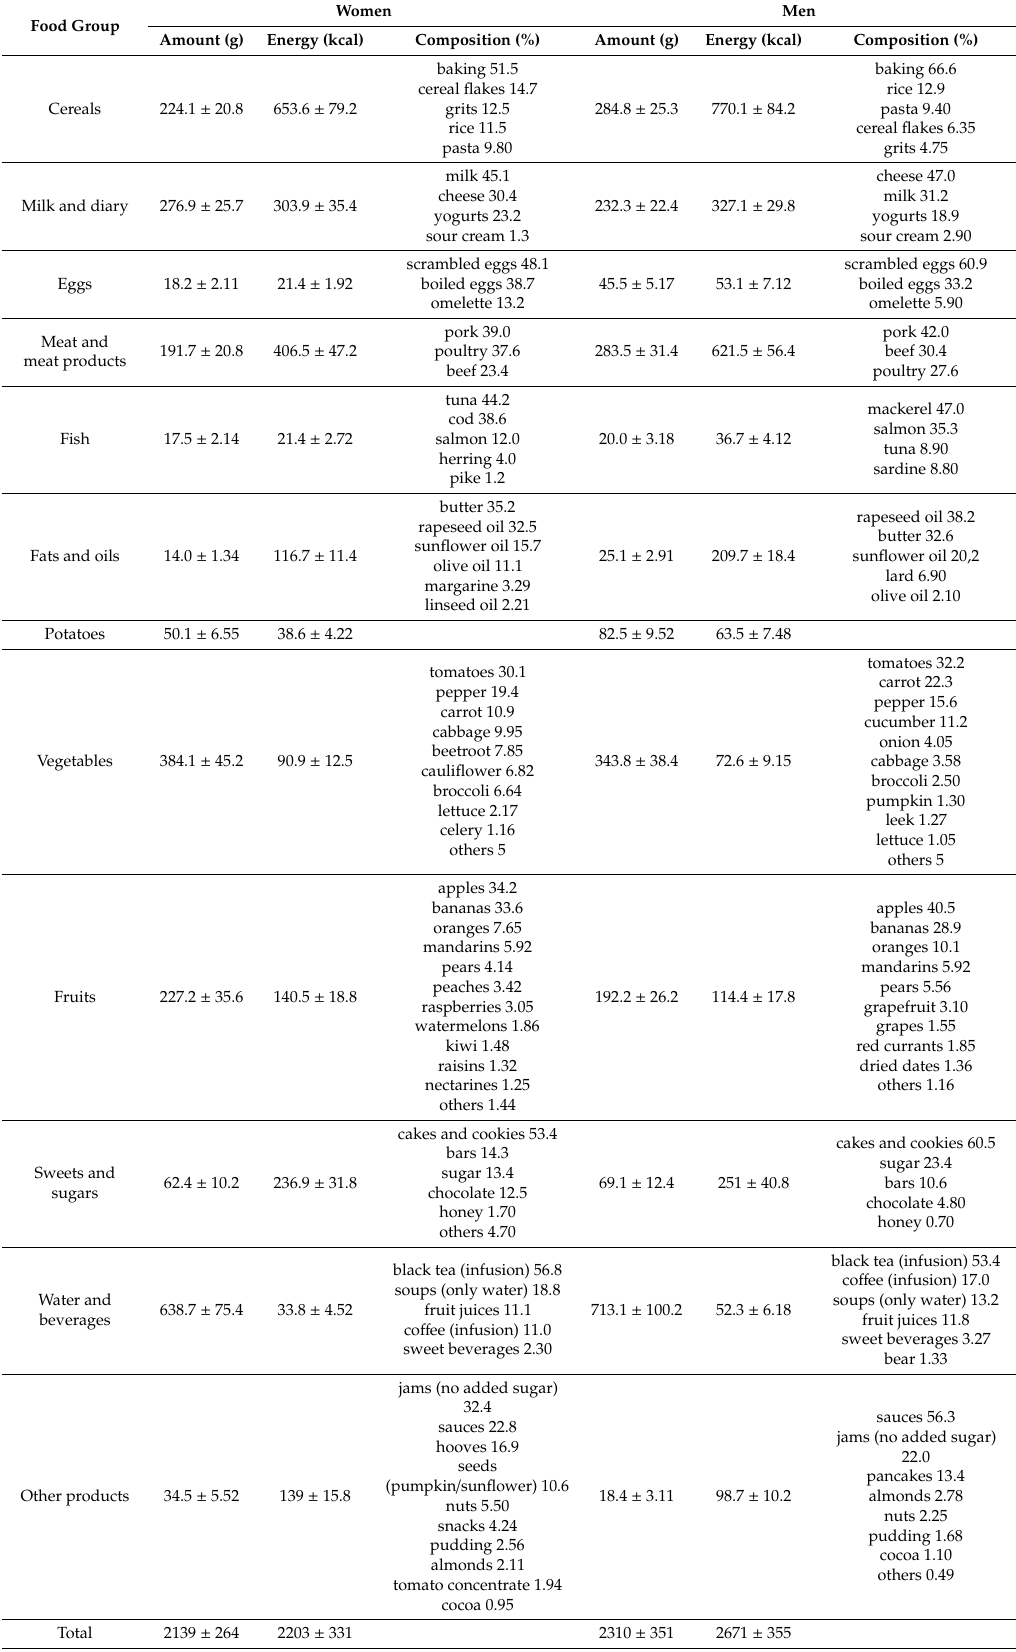
Table 3. Average daily intake of foods by food groups among women and